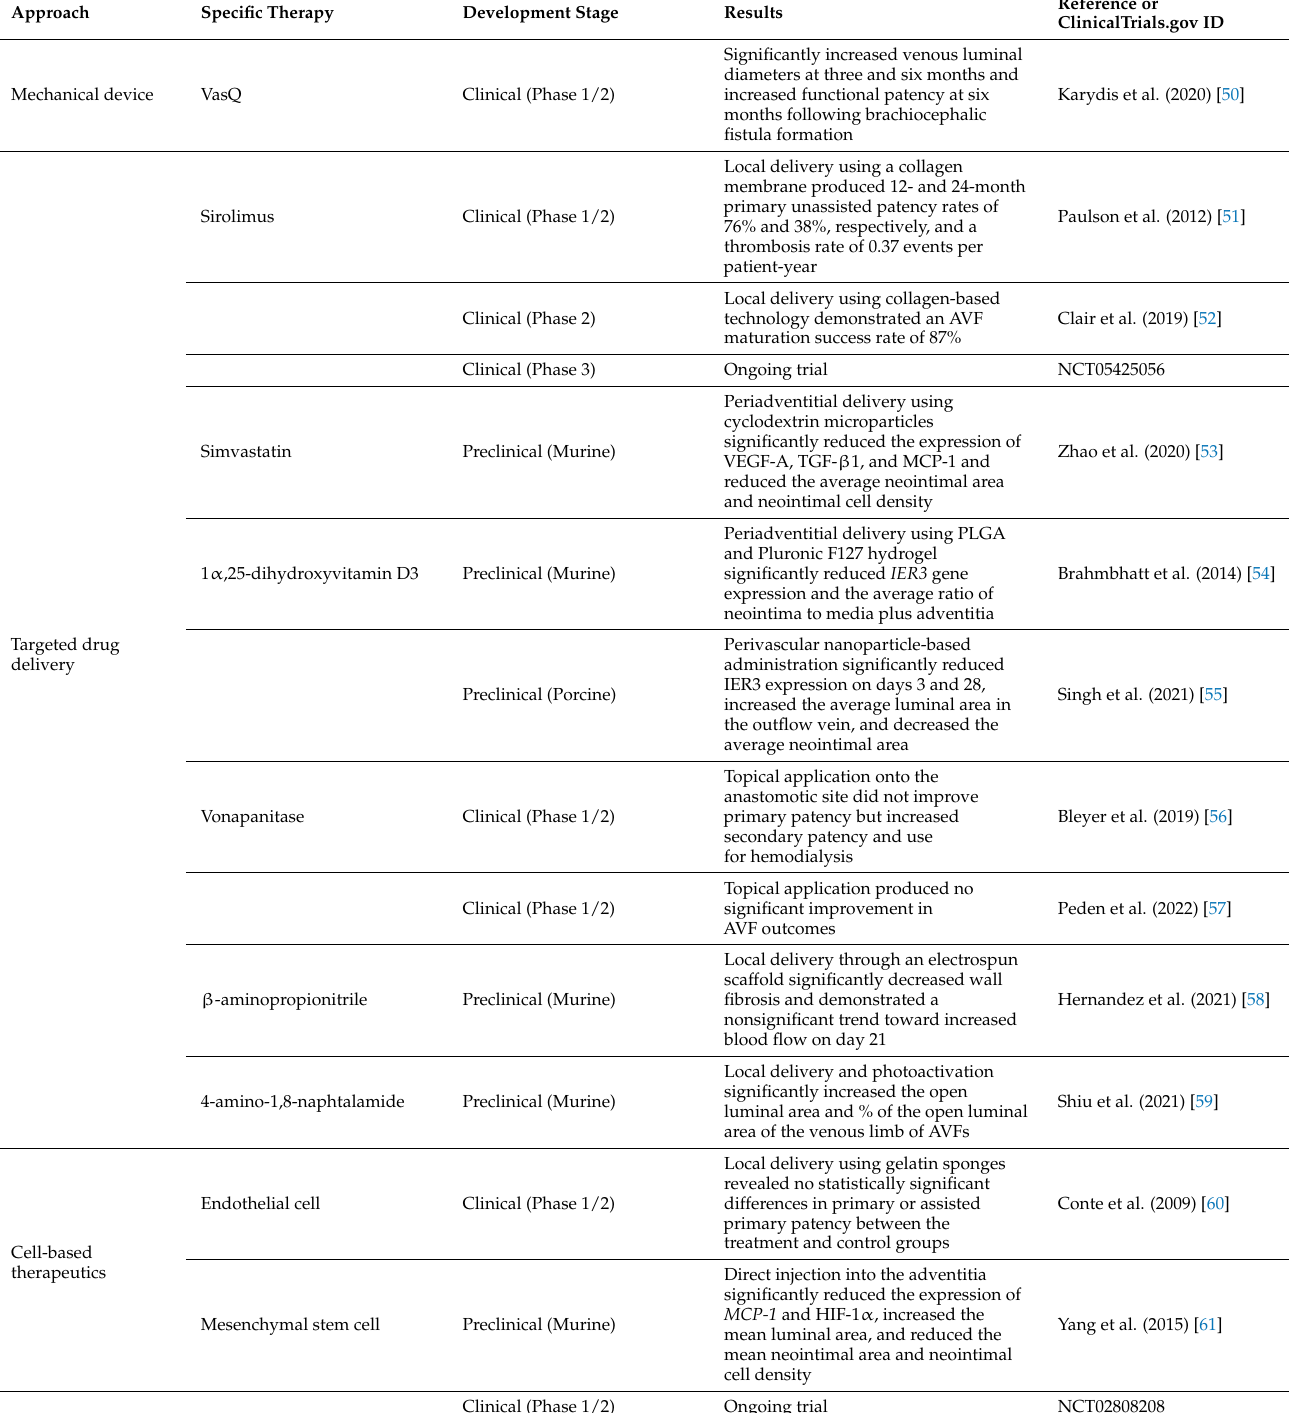
Table 1. Localized perivascular therapeutic approaches for supporting AVF